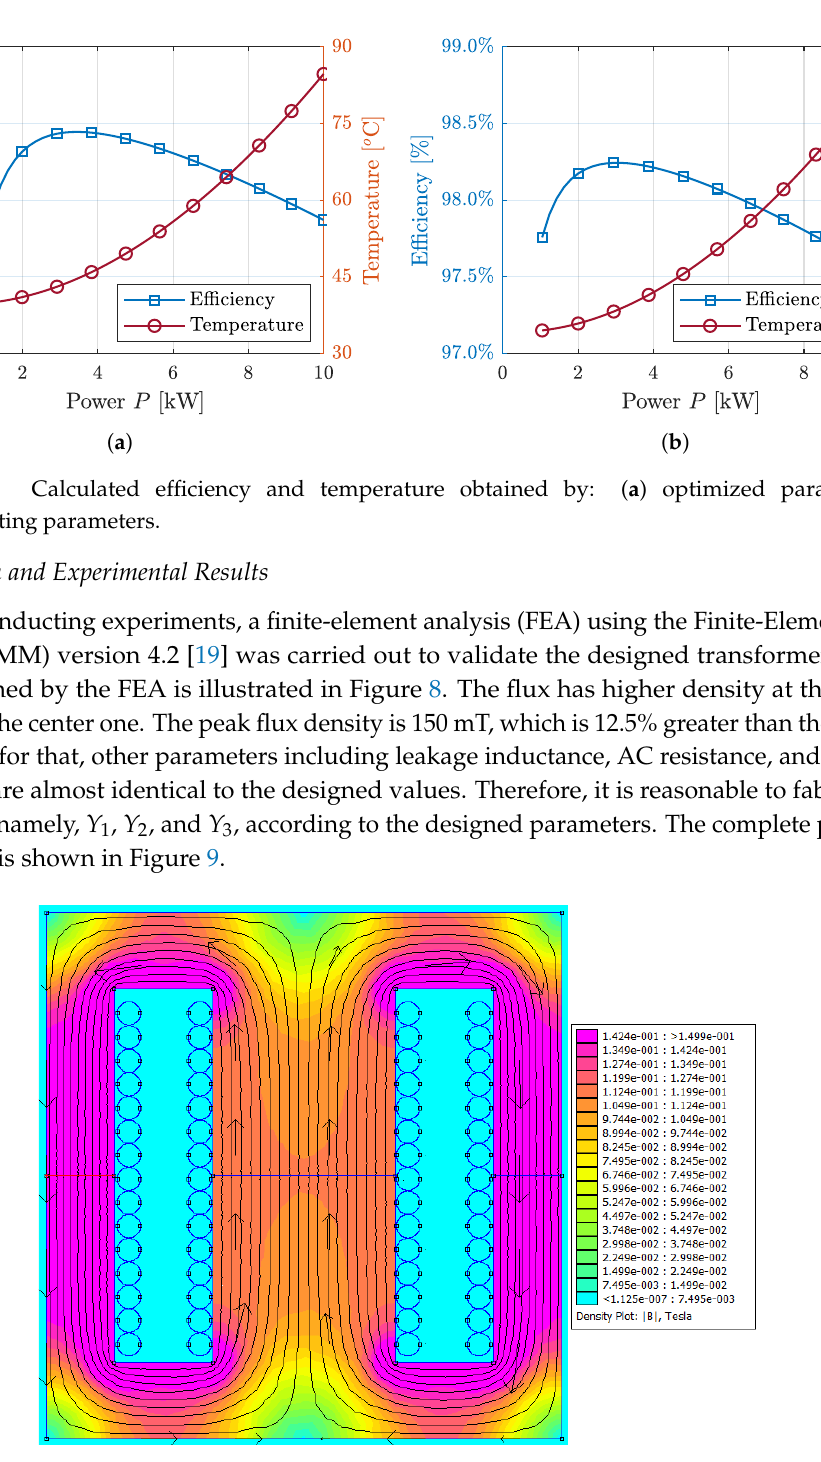
Figure 8. Finite-element-analysis using FEMM